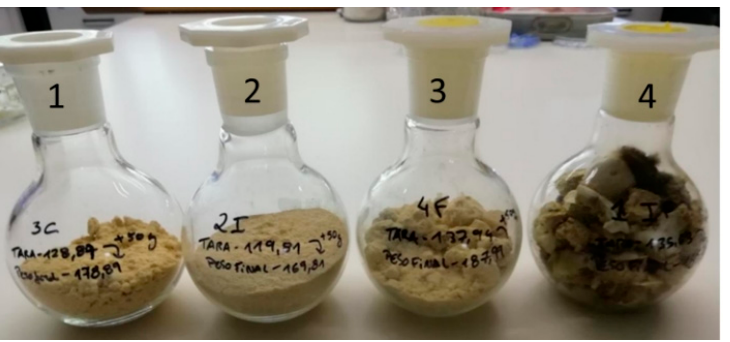
Figure 1. The final aspect of the interaction assays using maize flour: 1—control (containing only maize flour), 2—insect (maize flour and Tribolium castaneum ), 3—fungus (maize flour and Aspergillus flavus ) and 4—mixed (maize flour, T. castaneum and A. flavus ).